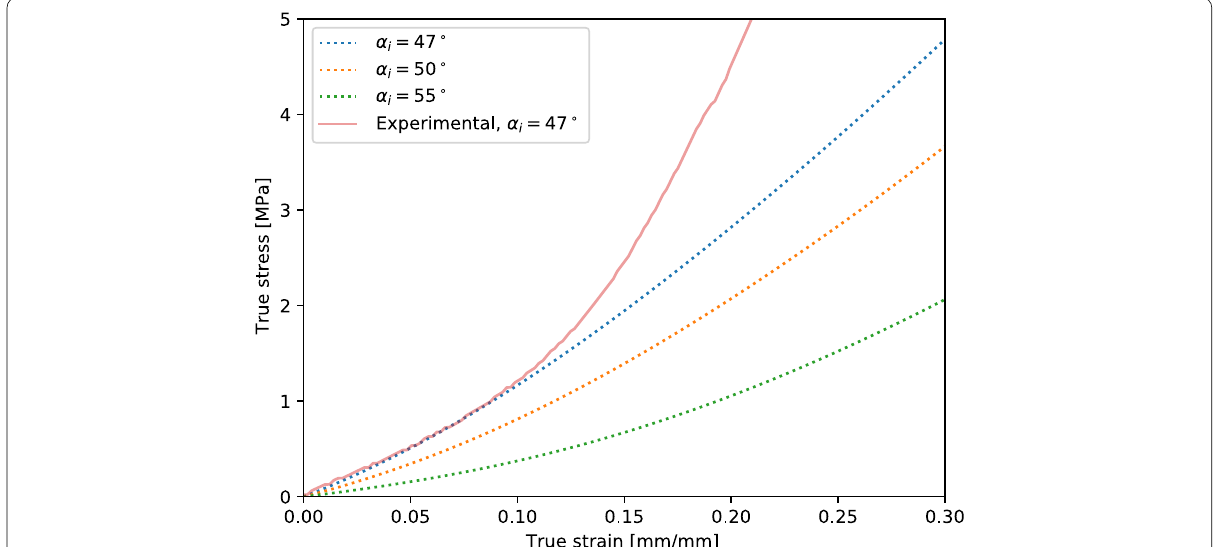
Fig. 5 Theoretical true stress–strain curves of braid on core composite for different initial braiding angles compared to experimental results for 8 yarns